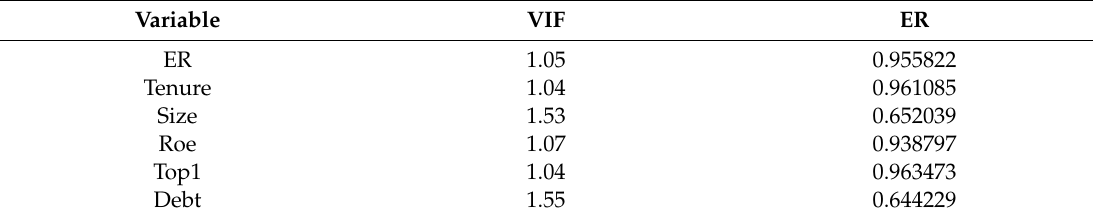
Table 4. Variance inflation factor (VIF) statistics. Mean VIF: